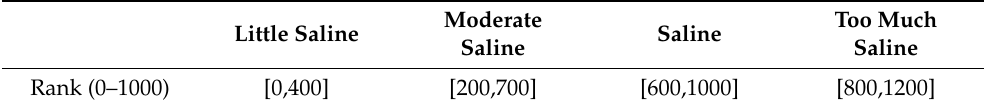
Table 4. Electric conductivity fuzzy